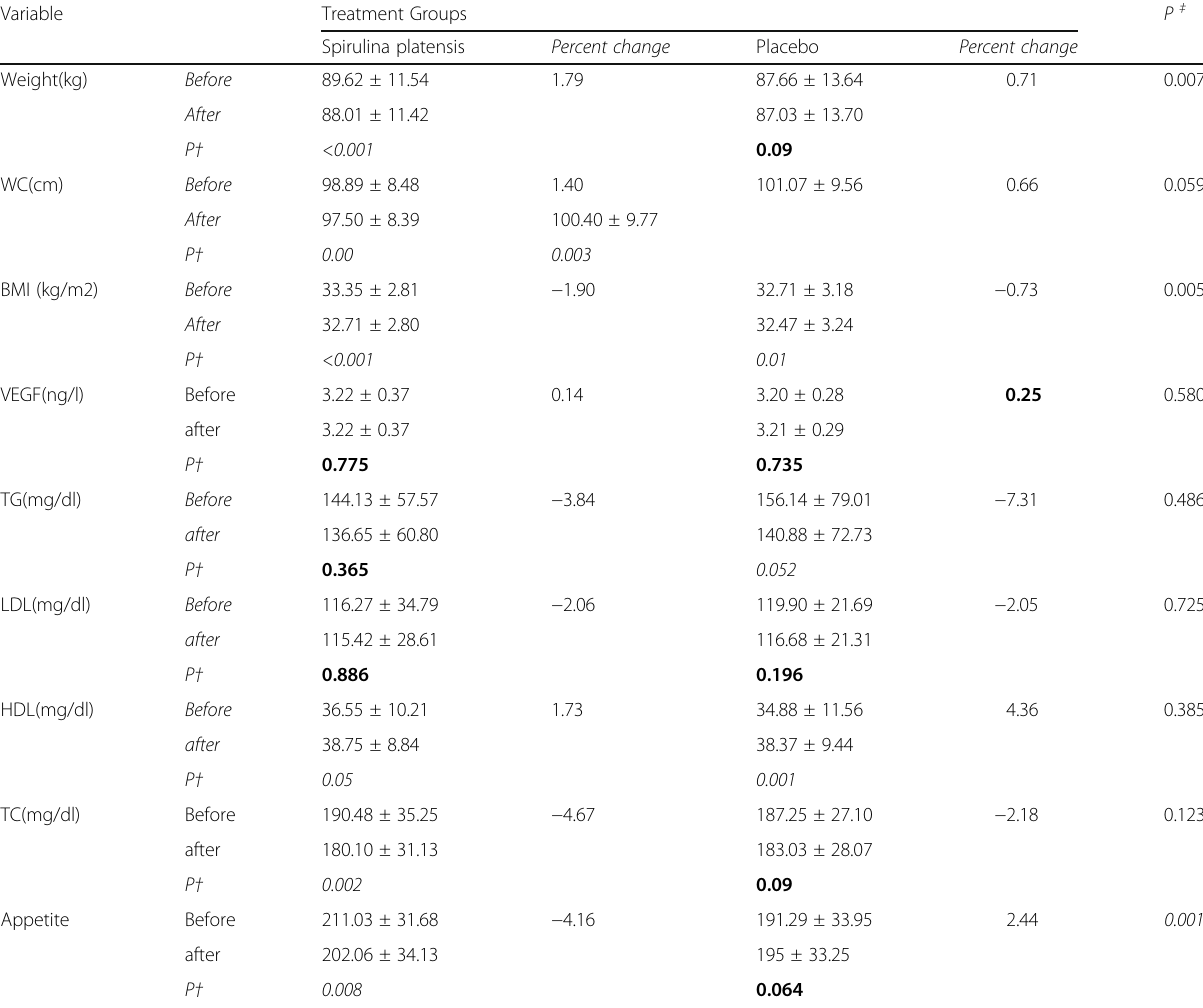
Table 4 Anthropometric and metabolic parameters in study groups before and after